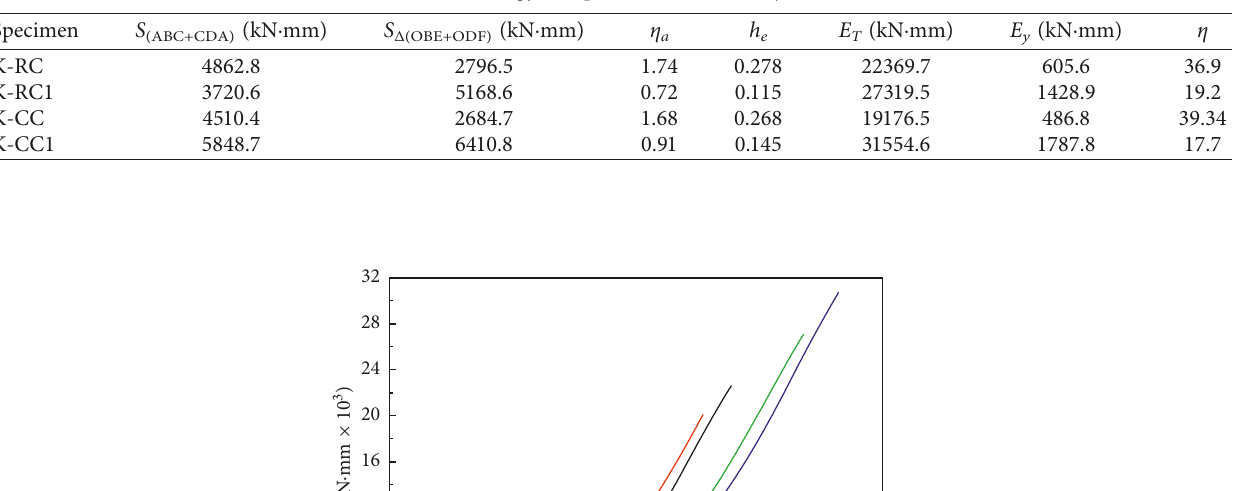
Table 4: Energy dissipation details of the joints.